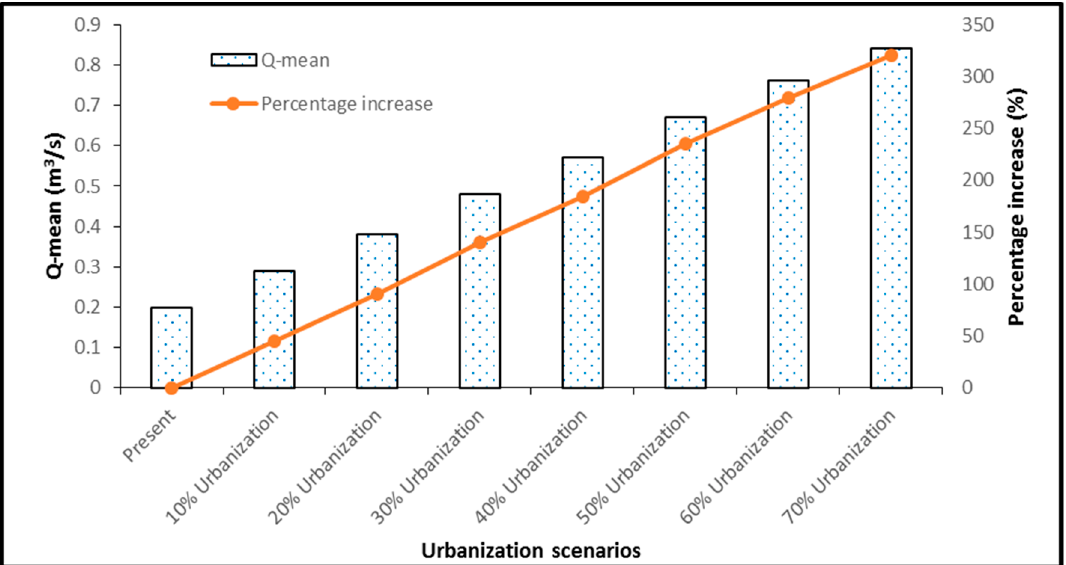
Figure 8. Urbanization effects on mean daily flow.